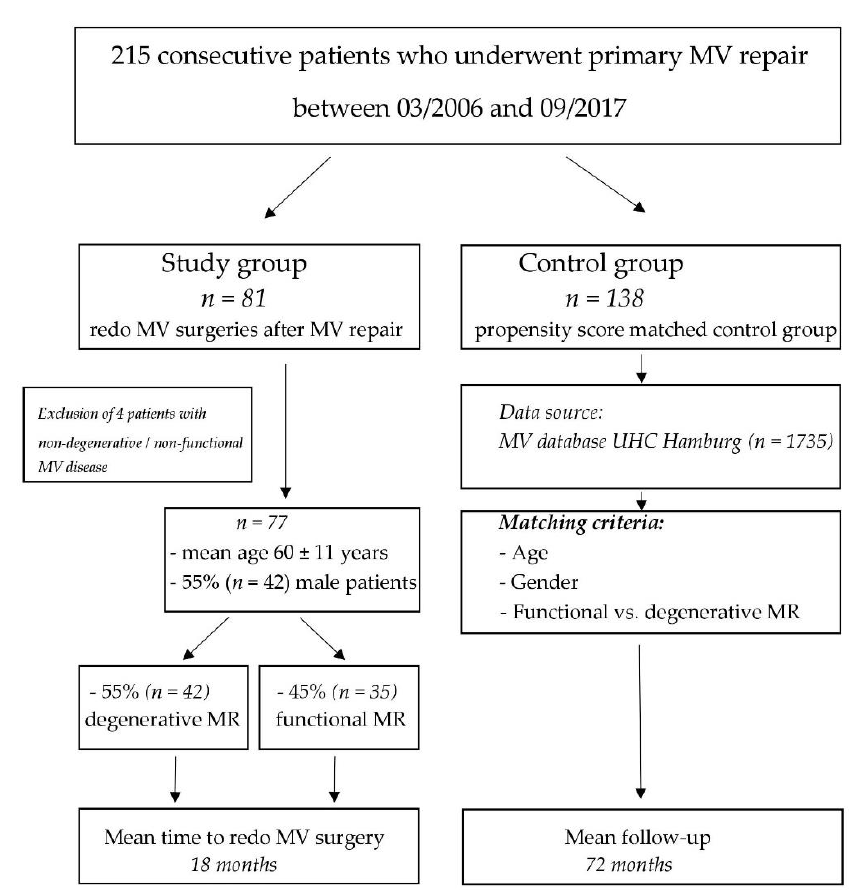
Figure 1. Patient enrollment flowchart. MV, mitral valve; UHZ, University Heart Center, Hamburg; MR, mitral regurgitation; SAM, systolic anterior movement.